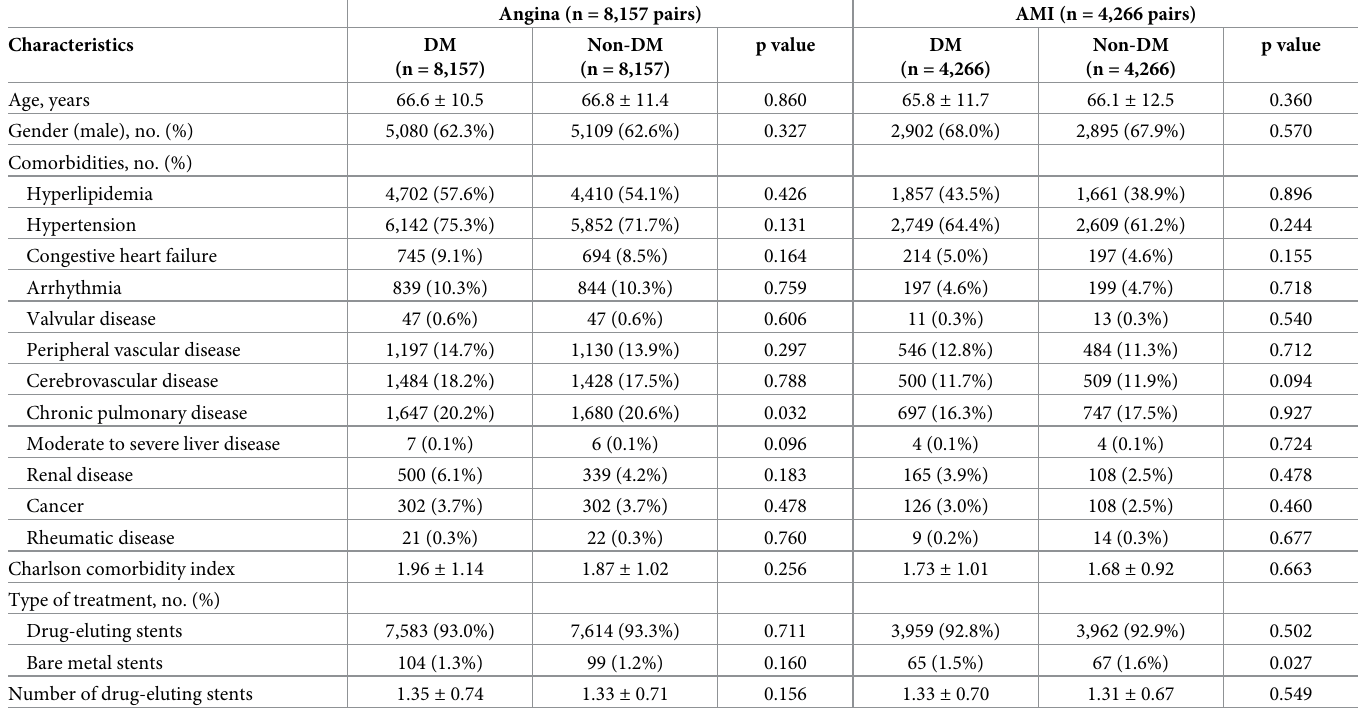
Table 2. Characteristics of the propensity score-matched patients according to the presence of diabetes mellitus.